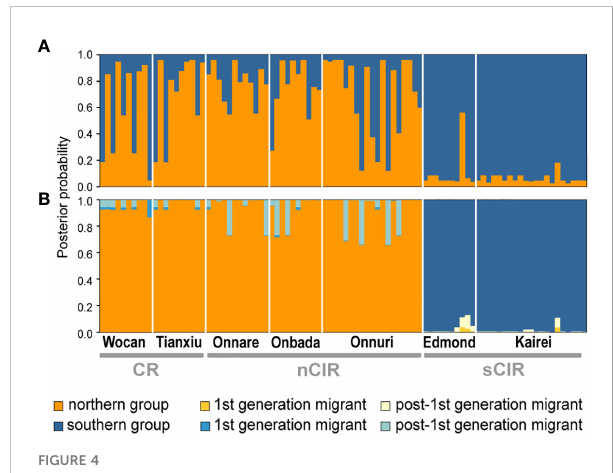
FIGURE 4 Genetic structure and recent migration of Alviniconcha populations in the Indian Ocean. (A) STRUCTURE analysis ( K = 2). Colors of bar represent assigned clusters K of each individual into the northern group (orange) and southern group (blue). (B) BayesAss estimation. The colors of the bar represent the posterior probabilities of native and migrant ancestries estimated from the genotypes of each individual. The migrant ancestries were colored with a similar color tone to the native